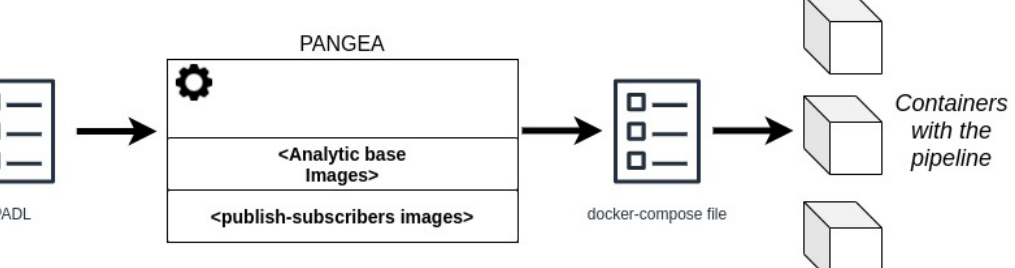
Figure 5. Development process aimed at automatically creating a set of docker containers, start- ing from a PADL document, to test and validate an analytic pipeline before being deployed in a production environment.